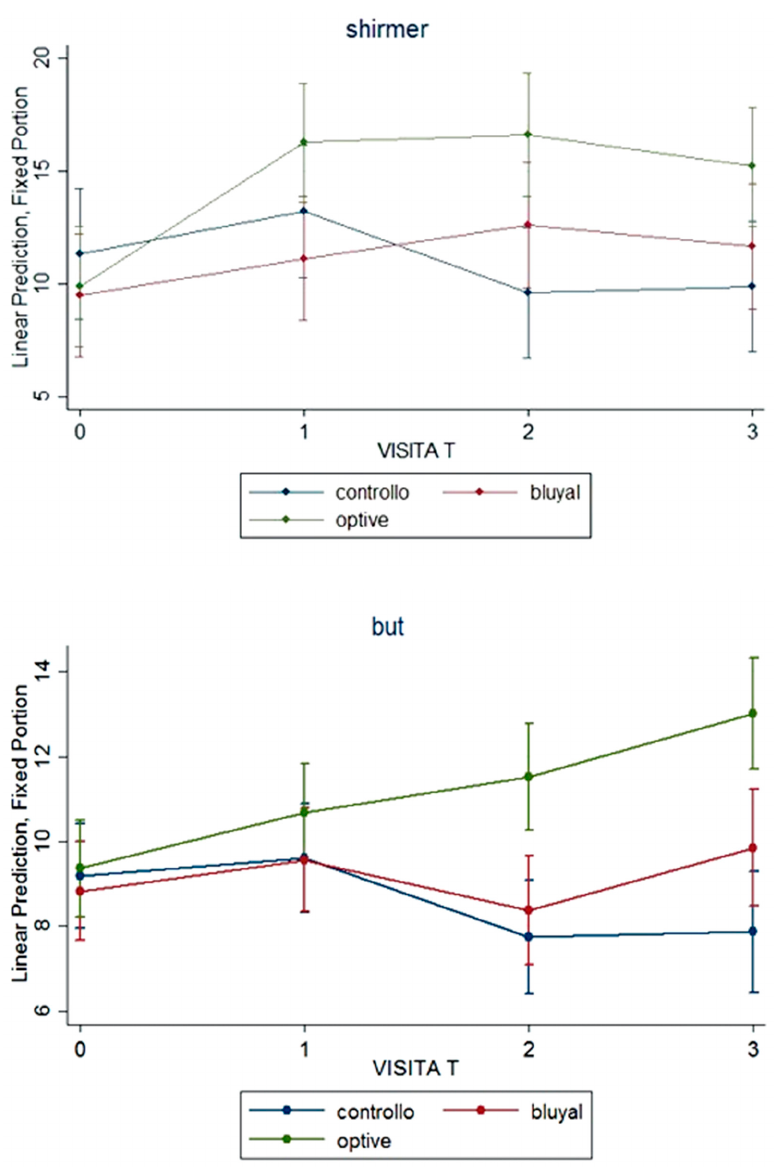
Figure 2. Signs of dry eye: Shirmer test and break-up time (BUT) over the time in the three groups. 3.2. Symptoms Vision-related quality of life examined with NEI-VFQ 25 revealed a good quality of life with an high total mean score at baseline that slightly improved after surgery. General vision (GV), near activity (NA) and vision-specific dependency (VSD) subscales improved